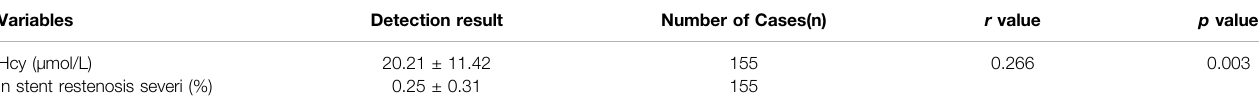
TABLE 6 | Pearson correlation between serum Hcy value and in stent restenosis severity.